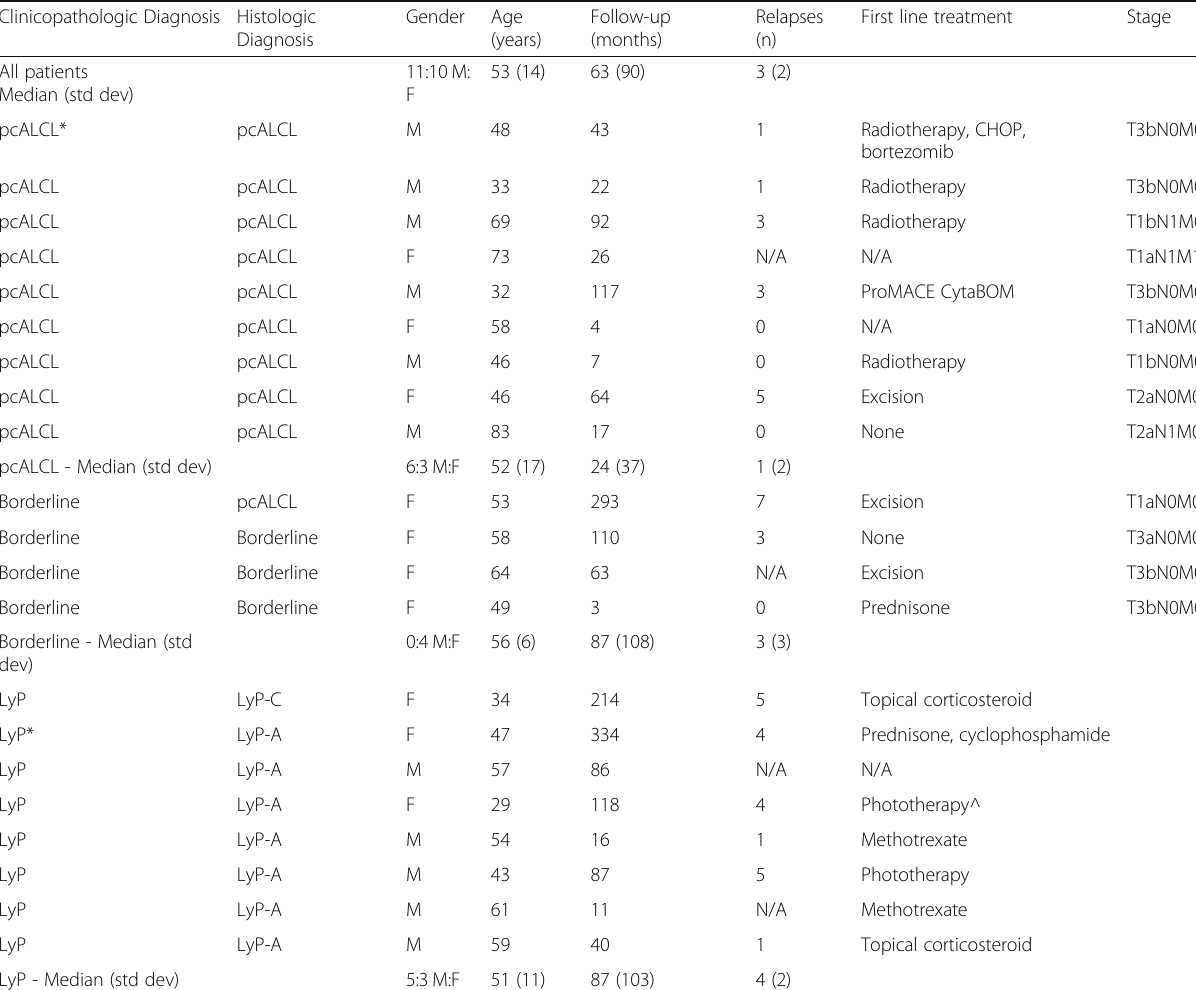
Table 1 Clinicopathological data Clinicopathologic Diagnosis Histologic